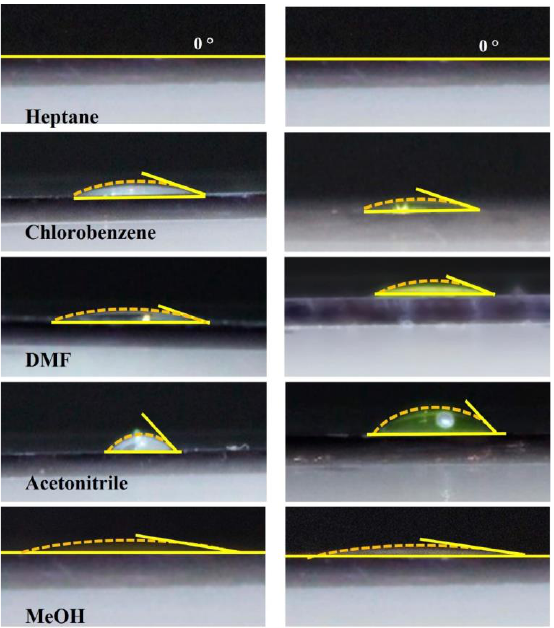
Figure 4. Contact angle for pure solvents ( left ) and solution used for film deposition ( right ).